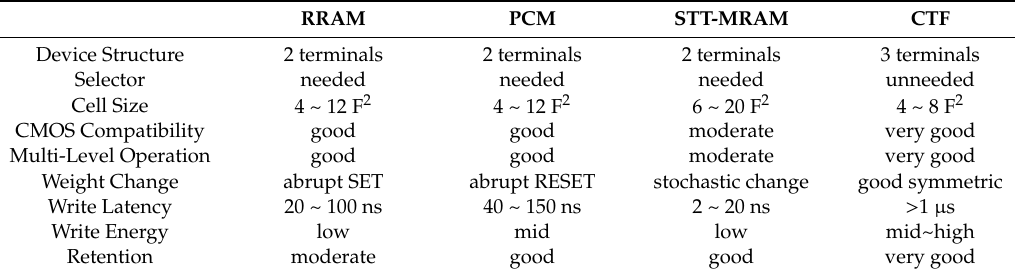
Table 1. Comparison between non-volatile memory devices for neuromorphic hardware